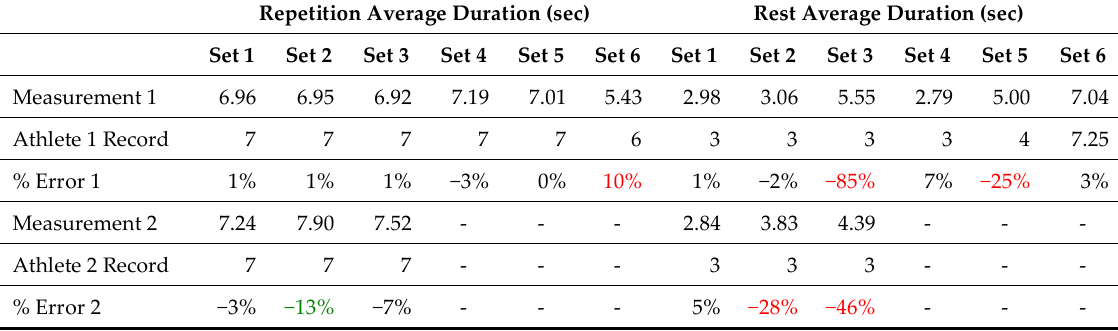
Figure 4. Force Measurements for “athlete 1”. This displays 2 grips, 3 sets each (6 total sets) and 18 total repetitions per grip (36 reps total). Table 1. Force Board measurement comparison to the athlete’s records. Color indicates the athlete error is more than 10%. If green, the athlete under-reported his/her effort, if red, he/she exaggerated the